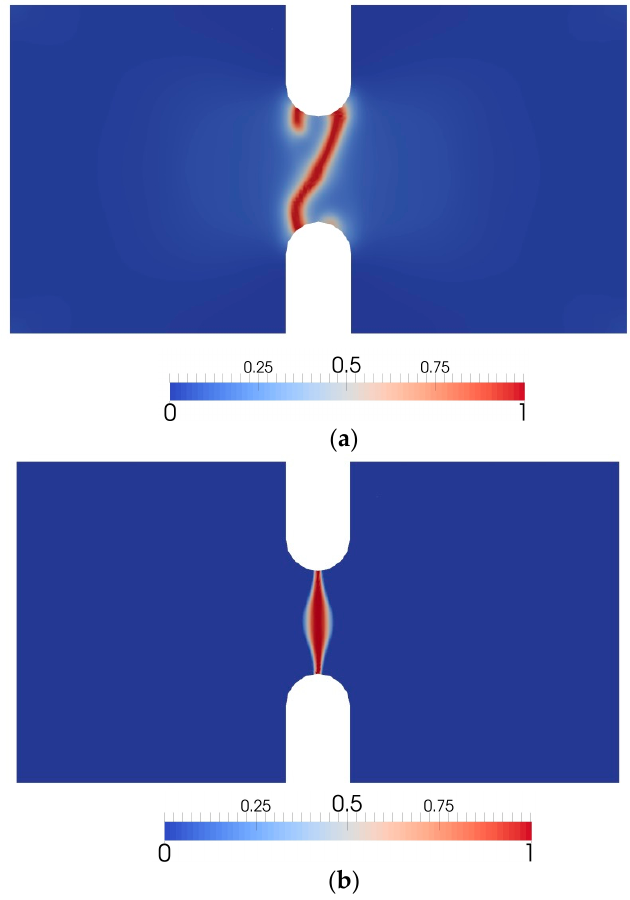
Figure 10. The final phase field distribution of the U-notched plane strain sample at ( a ) low loading rate and ( b ) high loading rate.